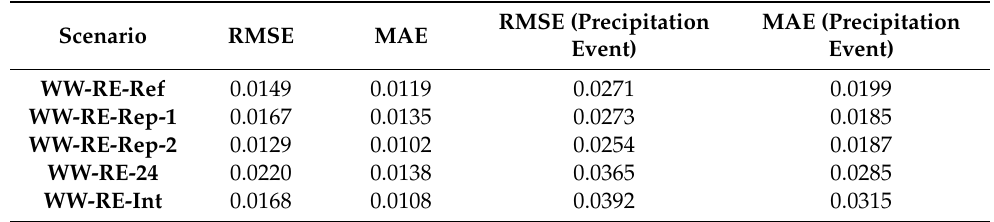
Table 8. Model fit to observation regarding water content (cm 3 cm − 3 ), jointly calculated over the total simulation time and the time most influenced by the precipitation event and over all observation points P1–P7 for joint ditch scenarios “jnt.”. RMSE (Precipitation MAE (Precipitation Scenario RMSE MAE Event)